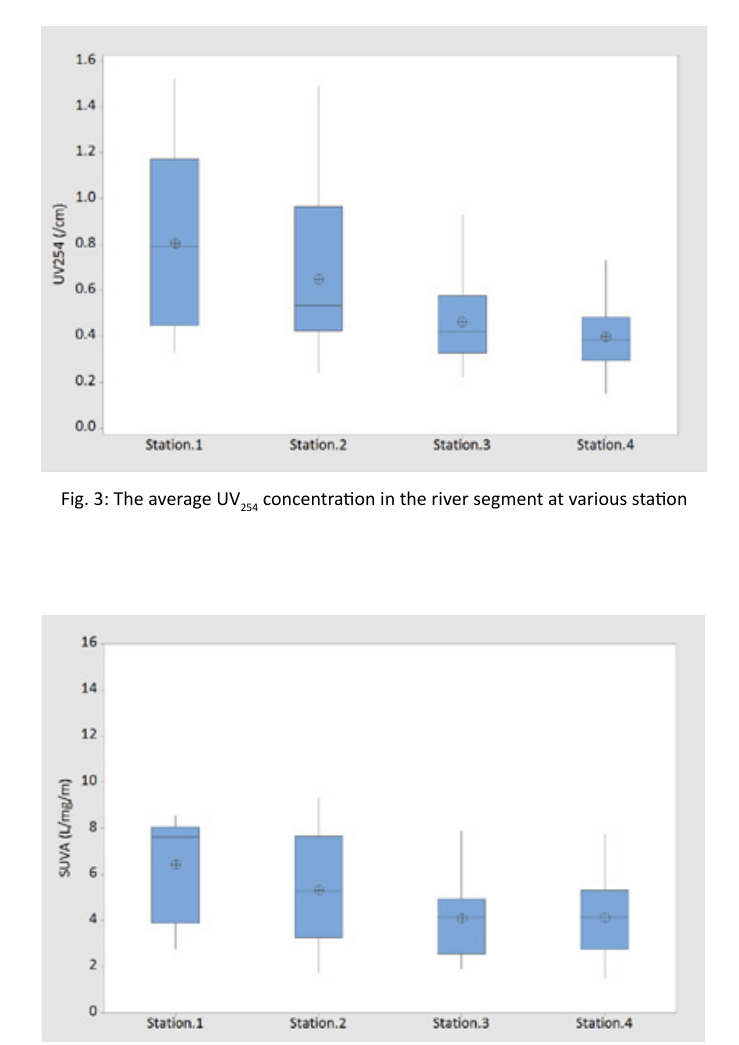
Fig. 4: The average SUVA value in the river segment at various station4